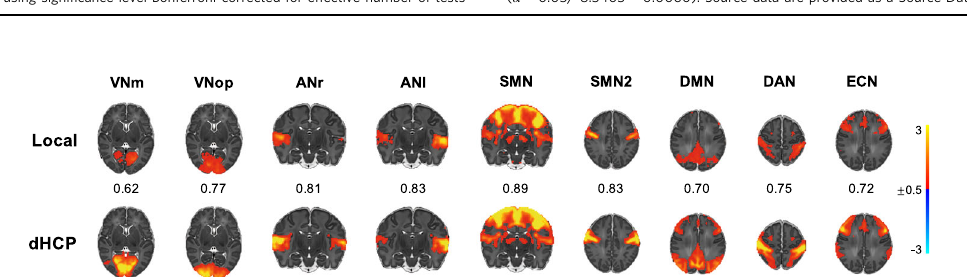
T -testresultsassessthegroupaveragepresenceorabsenceoftemplateexpressionwithintheneonates ’ ( n = 18)noxious-evokedresponsemaps(seeFig.2bi).T-statisticsand p -valuesarepresentedfor eachtemplate. Correlationresults assessthe correspondencebetween the inter-individualvariability in overallnoxious-evokedresponse amplitudes andthe correspondencebetweenneonates ’